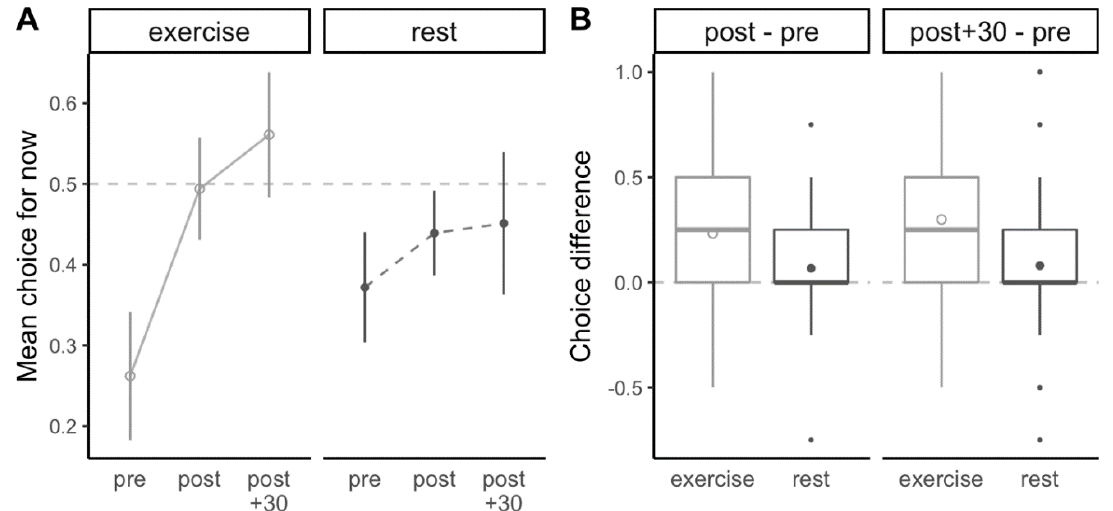
Figure 4. ( A ) Intertemporal food preference at each time point during the experiment. Values >0.5 indicate a greater preference for immediate consumption, and values <0.5 indicate a greater preference for delayed consumption. ( B ) Changes in intertemporal food preferences from before to immediately after the exercise/rest bout (post-pre) and from before to 30 min after completion of the exercise/rest bout (post+30 - pre). Positive values indicate an increase in the preference for immediate consumption, and negative values indicate an increase in the preference for delayed consumption. Circles represent means and error bars represent 95% within-subject confidence intervals, horizontal bars represent medians, boxes represent interquartile ranges, whiskers represent observations within 1.5 times the interquartile range, and outer points represent outliers.